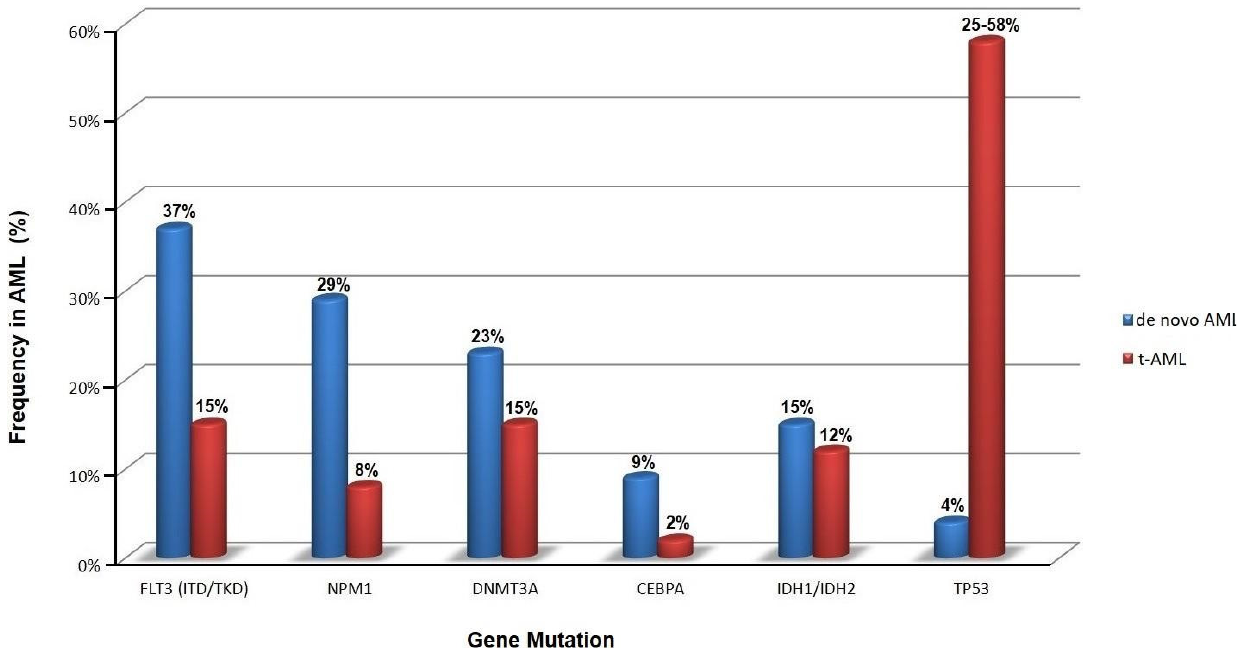
Figure 2. Frequency of somatic mutations in primary (de novo) and therapy-related acute myeloid leukemia (t-AML) at onset (data obtained from [16,32,33]). Different TP53 mutations occur at different stages in the course of AML. For example, biallelic defects and multi-hit events take place at a very early stage during leukemogenesis. These mutations contribute to the creation of a dominant clone [46,47]. Monoallelic TP53 mutations, on the other hand, usually occur at later stages of the disease as subclonal events [46,47]. Monoallelic TP53 mutations may also coexist with other driver mutations such as SF3B1 , TET2 , DMT3A , and ASXL1 mutations [46,47]. TP53 mutations are associ- ated with complex or monosomal karyotypes and “chromosome shattering” (also known ments